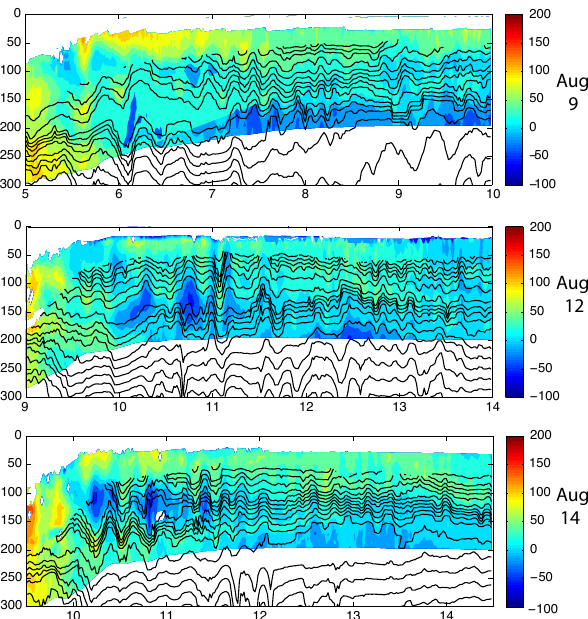
Figure 4. Isotherm displacements (black lines) over zonal velocity (color) for 5h just past the peak ebb tide for 9 August (top), 12 August (middle), and 14 August (bottom).